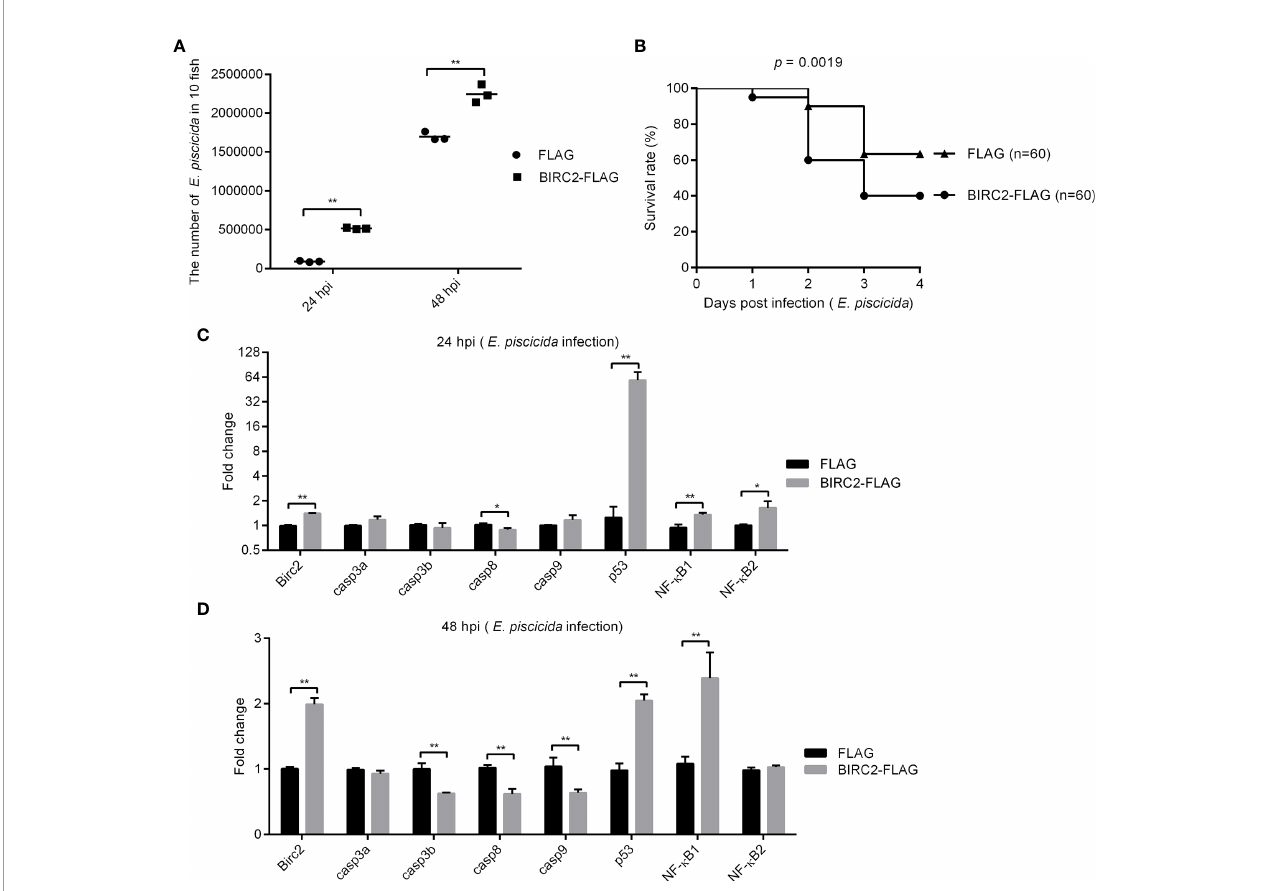
FIGURE 4 | Negative regulation of zebra fi sh BIRC2 on E. piscicida infection. (A) The effect of zebra fi sh BIRC2 on the bacteria proliferation. (B) The effect of zebra fi sh BIRC2 on the larvae survival in response to E. piscicida infection. (C, D) The effect of zebra fi sh BIRC2 on the expression levels of apoptosis-related genes and NF- k B genes at 24 and 48 hpi. Zebra fi sh larvae microinjected with the p3×FLAG plasmid were used for control group. The housekeeping gene GAPDH was used for normalizing the Ct values of target genes. The fold changes relative to 1 control group were calculated using the 2 − DD Ct method. Data represented the means ± the SEM (n = 3) and were tested for statistical signi fi cance using a two-tailed student ’ s t -test. * p < 0.05; ** p <